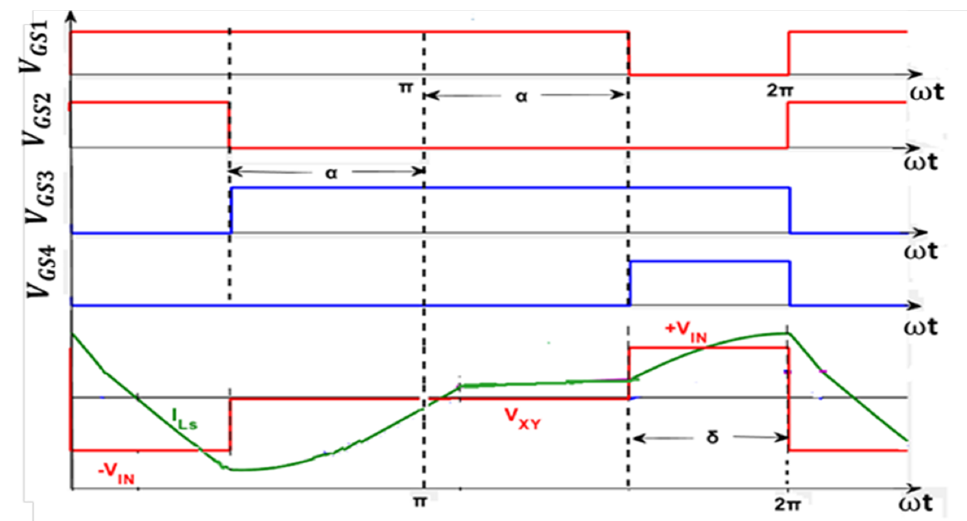
Figure 3. Switches gate signals voltage and current waveforms for the LLC resonant converter at arbitrary phase-shift.